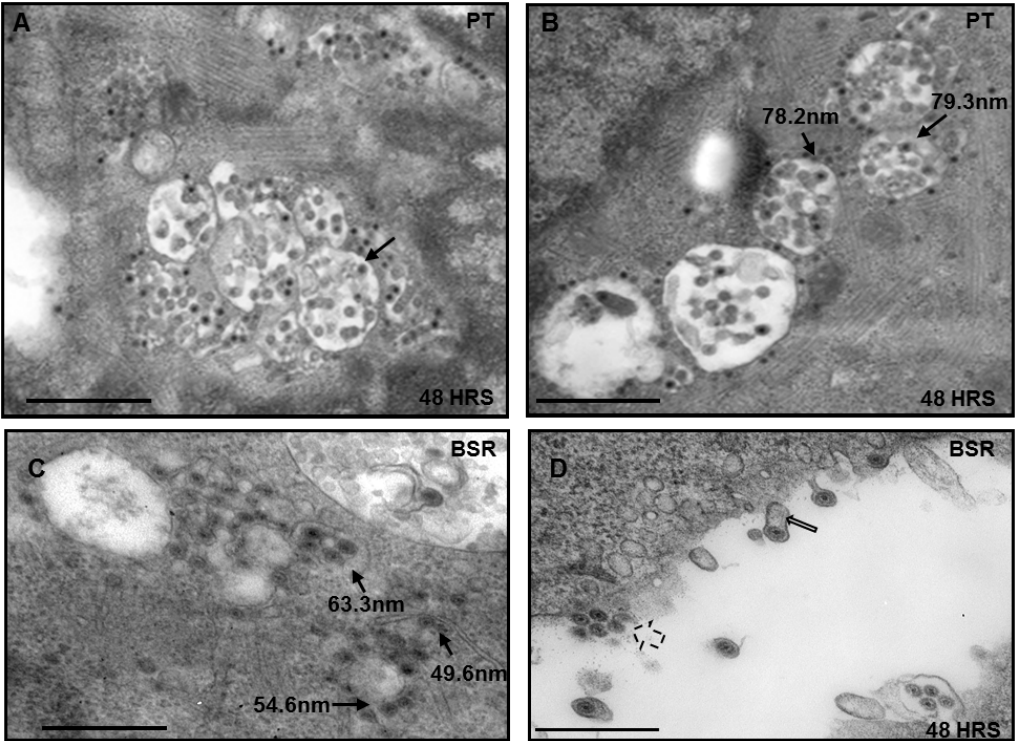
Figure 1. Electron Microscope analysis of infected cell sections. Both PT and control BSR cells were infected with Bluetongue virus (BTV), fixed and processed for cell sectioning. Virus particles in PT ( A , B ) and BSR ( C , D ) cells are associated with vesicles (thin black arrows) or released and attached to membranes (open black arrows). In BSR cells the particles can also be seen released by the perturbation of the plasma membrane (broken arrows). Bar, 500